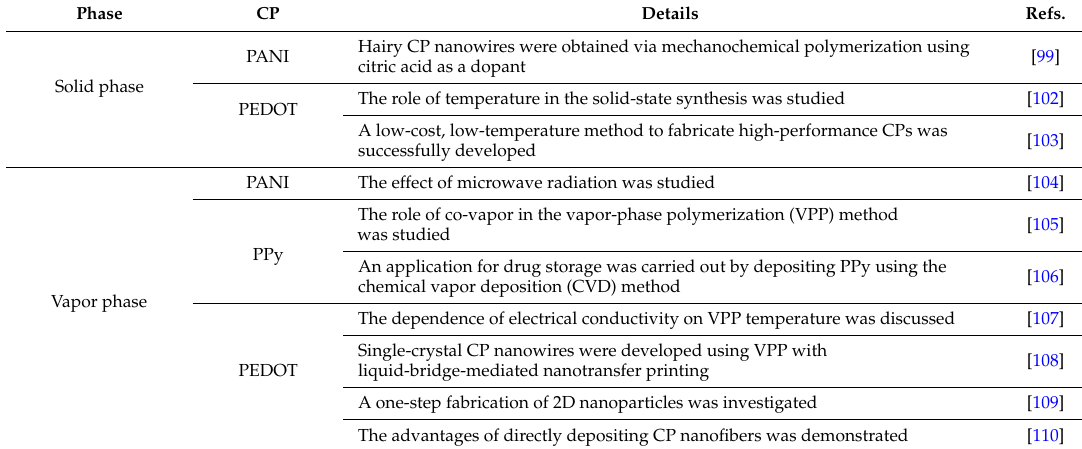
Table 5. Representative reports for the solid/vapor-phase polymerization of CP